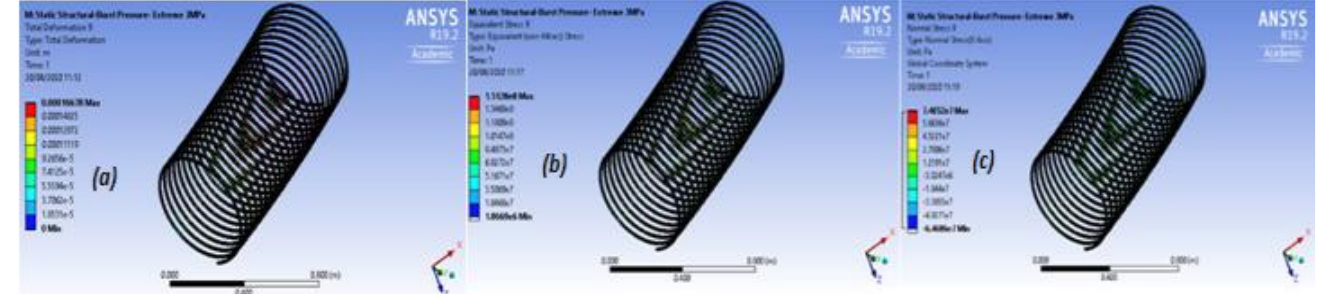
Figure 12. Burst loading on the helical spring reinforcement under operational conditions showing ( a ) total deformation, ( b ) equivalent von Mises stress and ( c ) normal stress (ends are free without end fittings in this case).